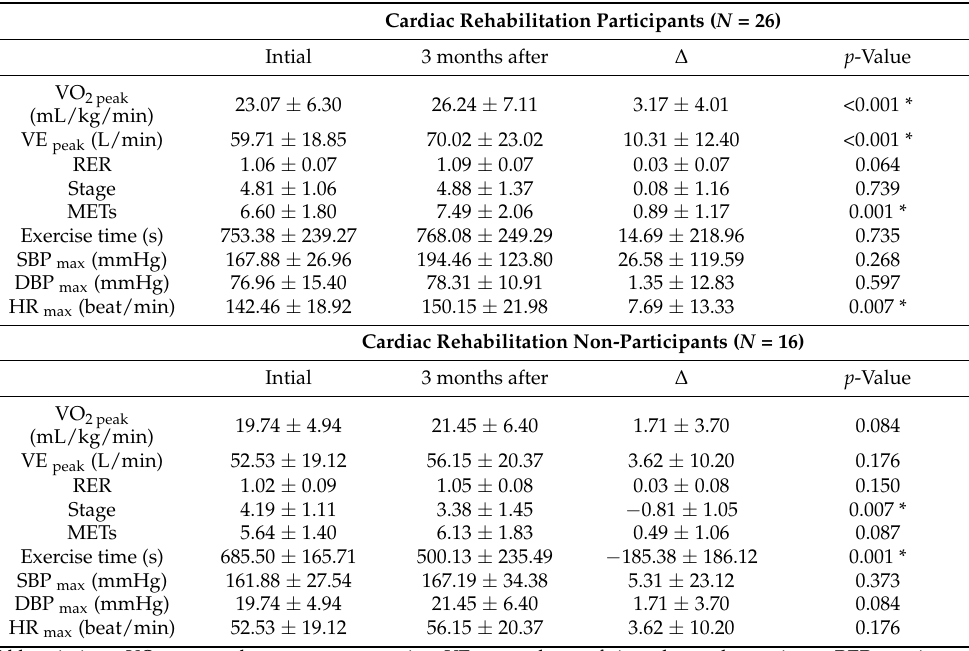
Table 3. Comparison in exercise capacity changes in the initial ETT and of the ETT the ETT that occurred 3 months later between the CR participants and